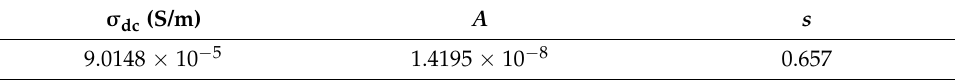
Figure 8. Change in ac conductivity of prepared PbSe along with the change of frequency. Table 1. The ac conductivity fitting parameters by Jonscher’s power